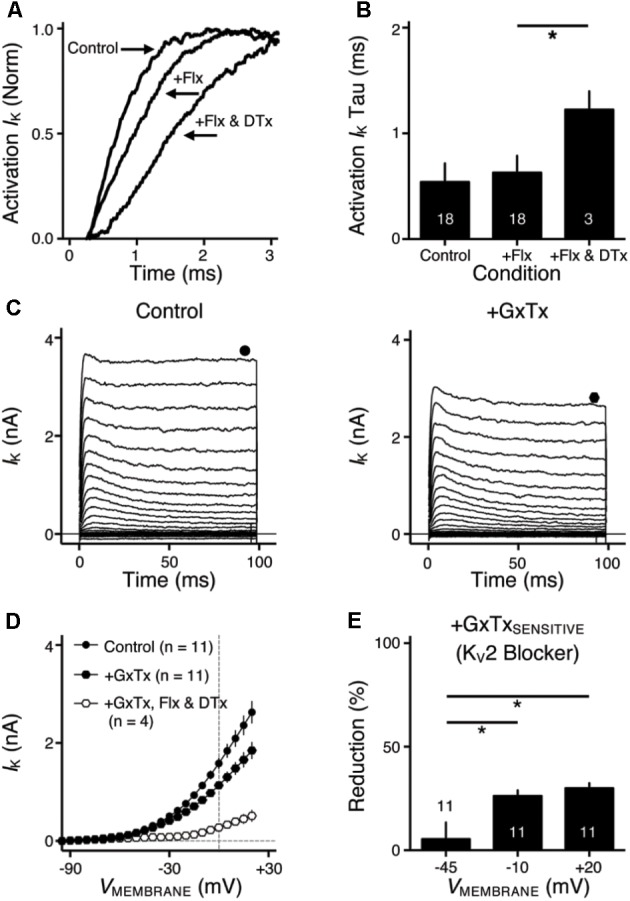
KV2 mediated current in NMc neurons. (A) Representative activation phase of KV current traces (activation IK) with normalization (norm) in control and during drug application. Flx, fluoxetine (100 μM). DTx, dendrotoxin (0.1 μM). (B) Population data showing the time constant (tau) of KV current activation phase. (C) Representative KV current traces (IK) in control and during drug application. GxTx, Guangxitoxin (100 nM). Symbols (circle and hexagon) at the end of current traces represent time window of measured steady-state (SS) KV currents. (D) Population data showing the relationship of steady-state (SS) KV currents to membrane voltages (VMEMBRANE) in control and during drug application. (E) Population data showing the percent reduction in steady-state (SS) KV currents due to the application of GxTx, at membrane voltages (VMEMBRANE) of +20, –10, and –45 mV. Error bar = standard error. ∗p < 0.05.